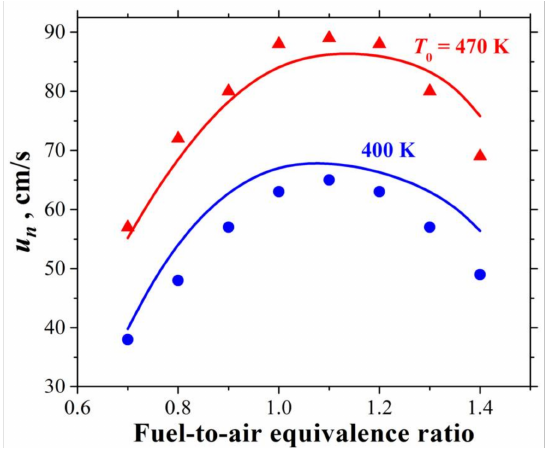
Figure 5. Calculated (curves) and measured (symbols) dependences of the laminar flame velocity on the fuel-to-air equivalence ratio for n-dodecane–air mixture at P = 1 bar and T 0 = 400 and 470 K.